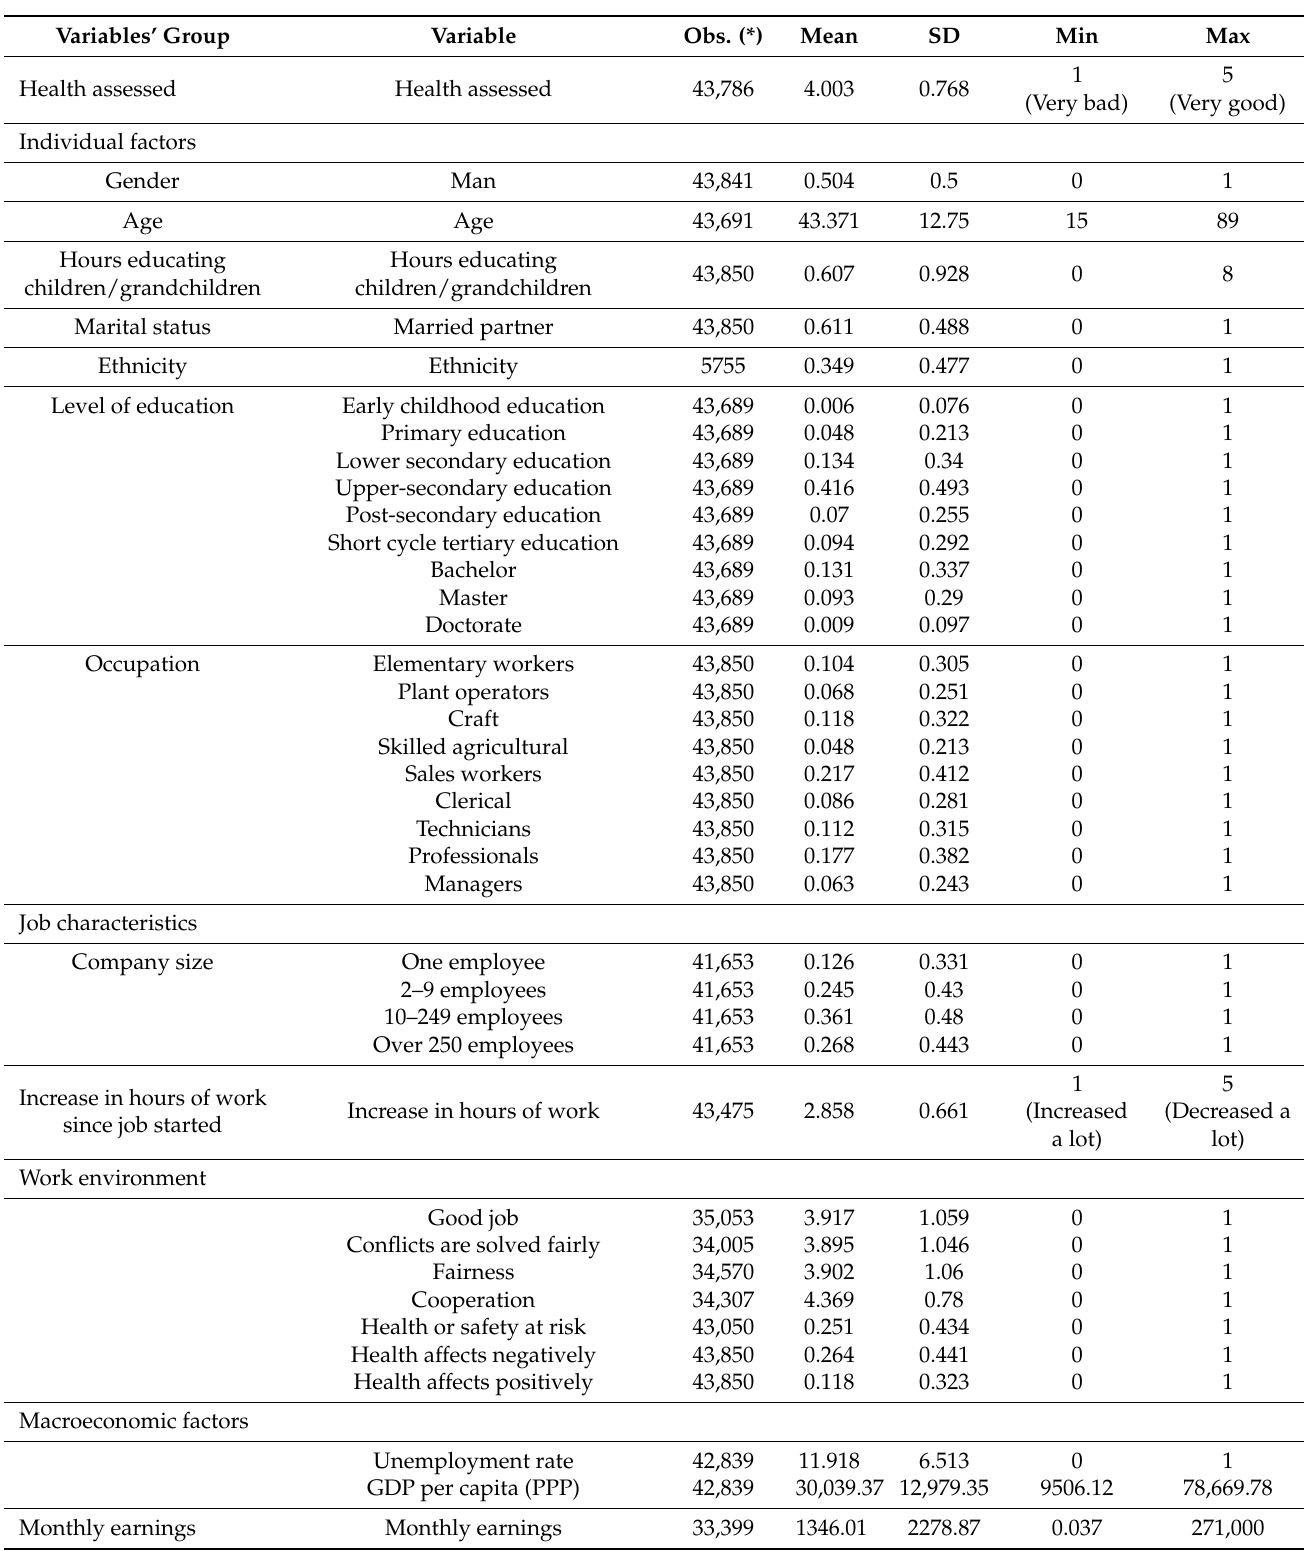
Table 1. Summary